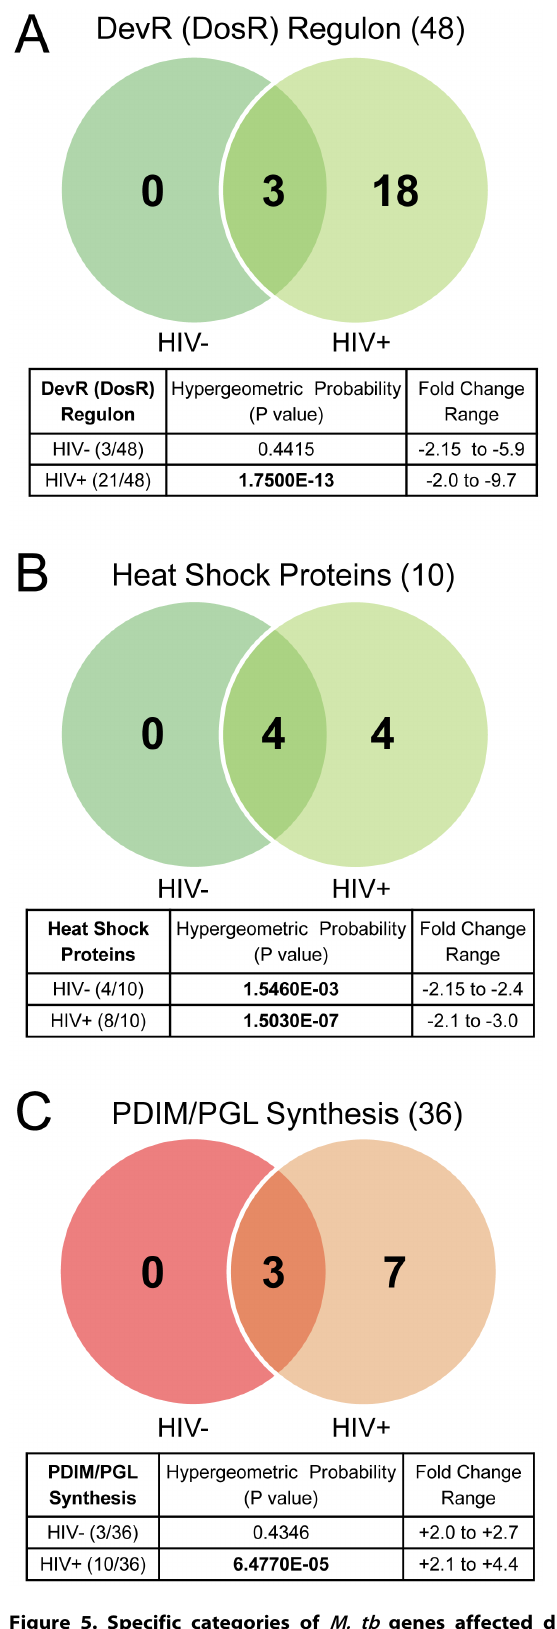
Figure 5. Specific categories of M. tb genes affected during growth in the blood environment. (A) DosR regulon genes (B) Genes encoding heat shock proteins (8) and stimulators of heat